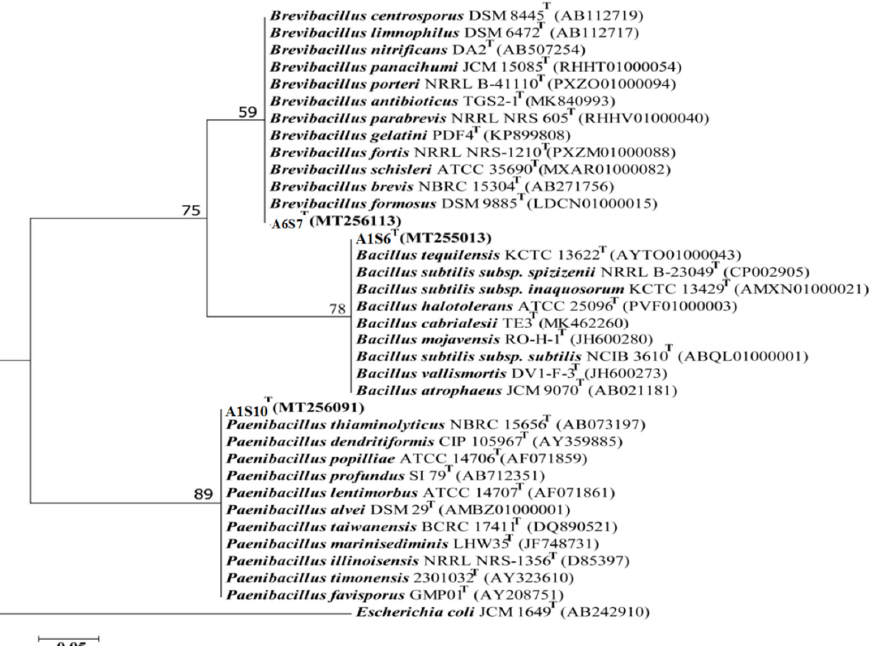
Figure 4. The phylogenetic tree by the Neighbour-joining model was constructed based on 16S rRNA gene sequences representing three different genera, i-e. Bacillus , Brevibacillus and Paenibacillus respectively. The bootstrap value above 60 (1000 replicates) is shown at branch nodes. E. coli JCM 1649 (AB242910) was used as an outgroup. Bar, 0.05 substitutions per nucleotide position.